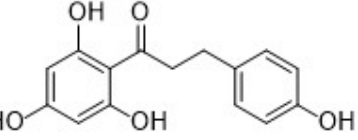
Figure 14. Chemical structure of phloretin (PH).